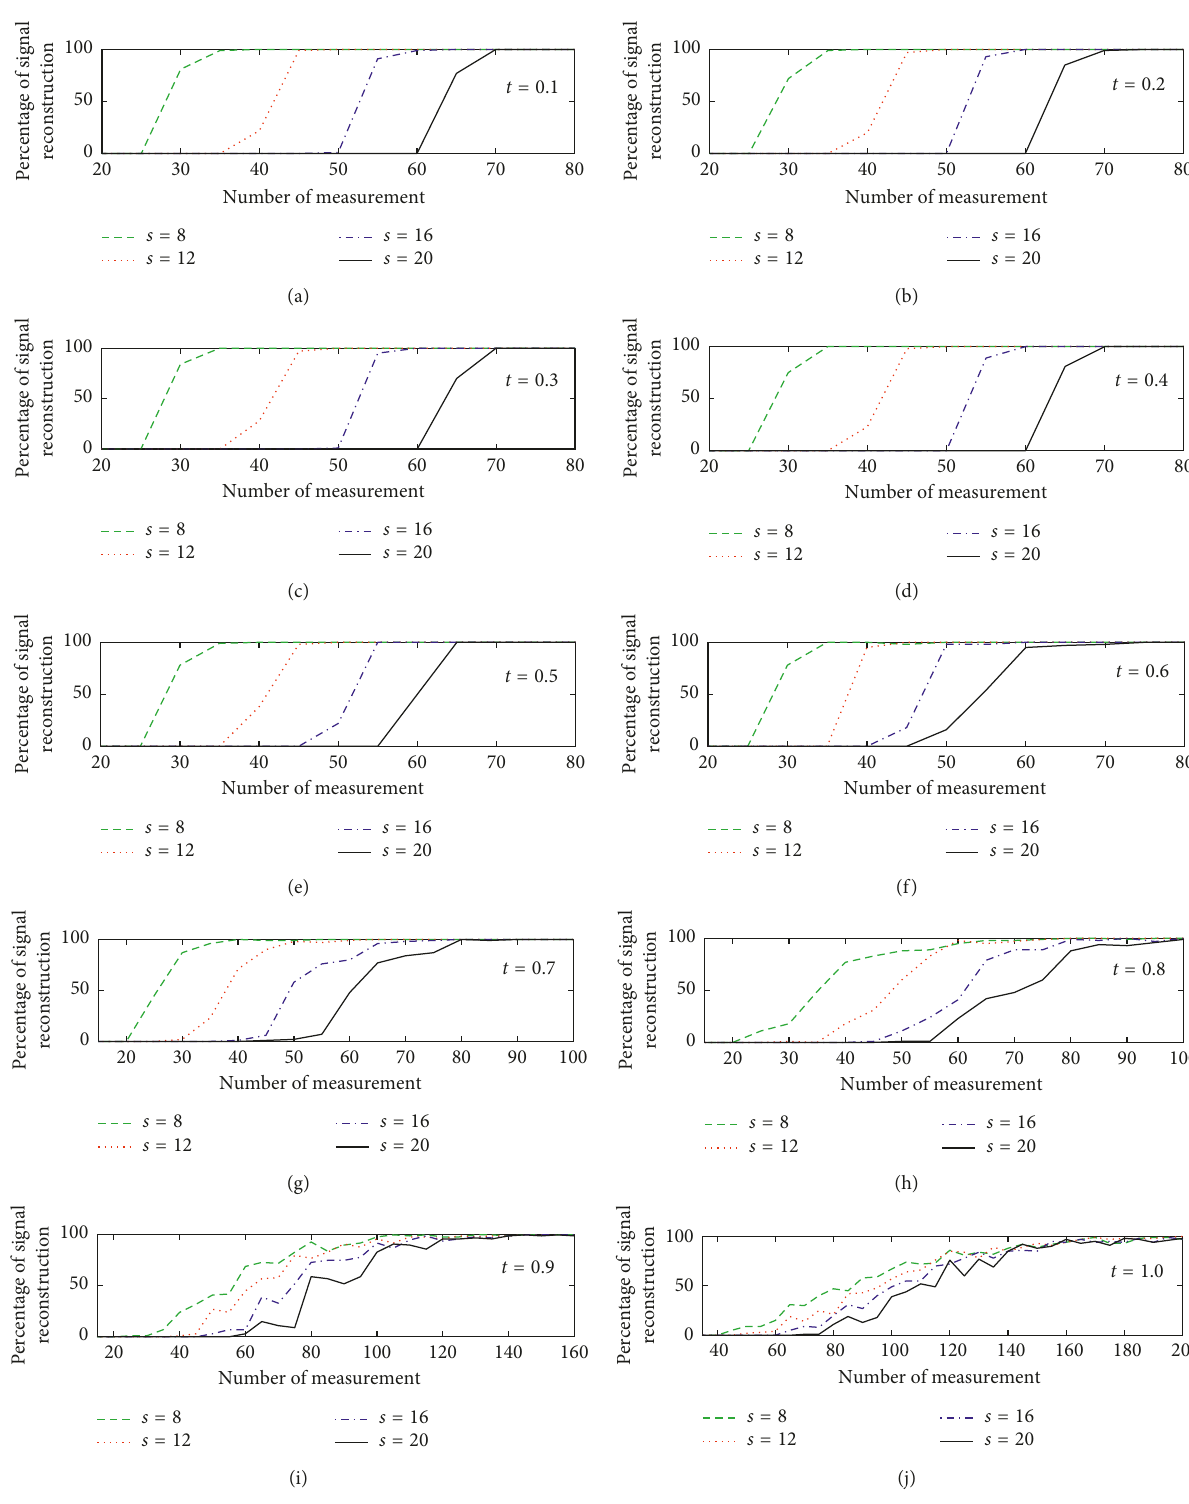
Figure 1: Reconstruction probability of different sparsity with different measurements in different threshold conditions ( n s 8 , 12 , 16 , 20 , t 0 . 1 1 . 0 , Gaussian [ ] [ ] ∈ ∈